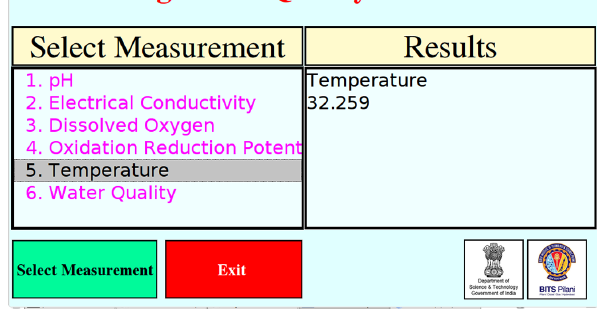
Figure 3. Graphical user